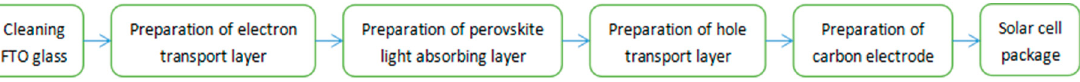
Figure 1. Flow schematic of device fabrication.